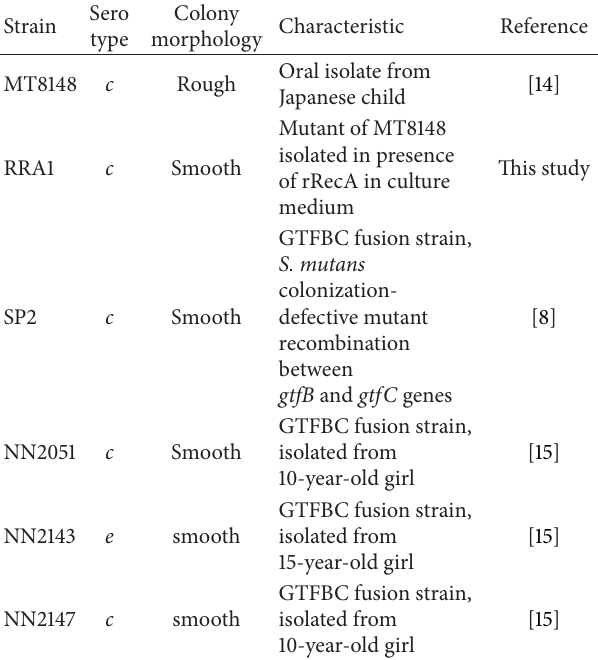
Table 1: Strains used in this